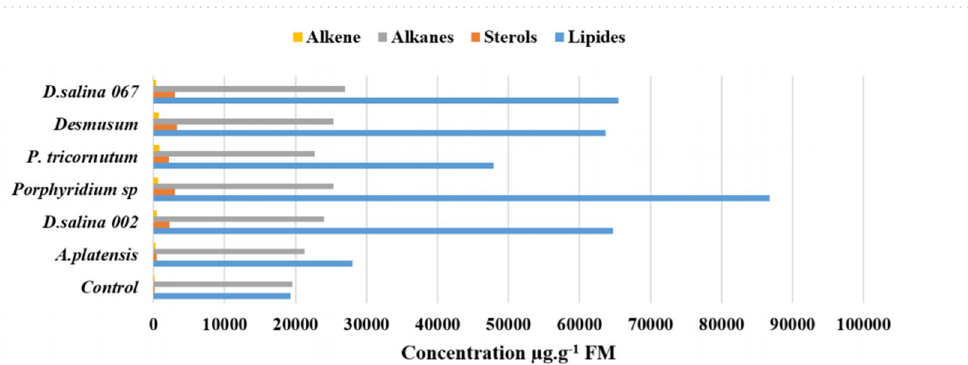
Figure 3. Metabolites profile of tomato plants leaves treated by polysaccharides. Tomato plants were injected with 1 mg mL −1 of PS, and H 2 O as